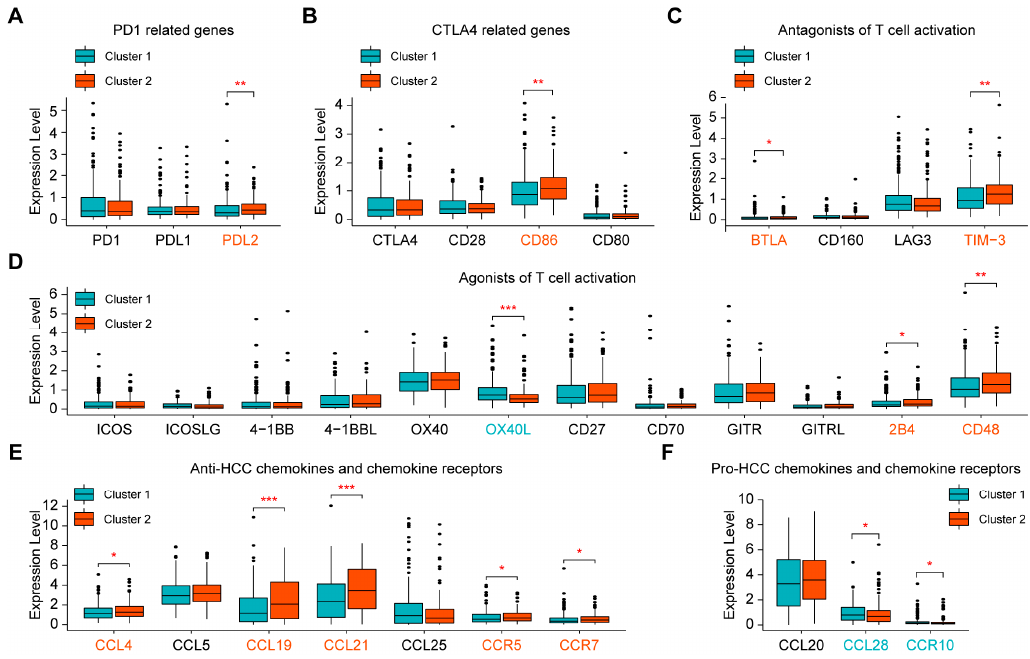
Figure 3. Evaluation of sensitivity to immunotherapy of the two clusters. ( A – D ) Comparison of the expression levels of immunomodulatory genes between Cluster 1 and Cluster 2. ( E , F ) Comparison of the expression levels of known chemokines and chemokine receptors that regulate the progression of HCC between Cluster 1 and Cluster 2. * p < 0.05, ** p < 0.01, *** p < 0.001.